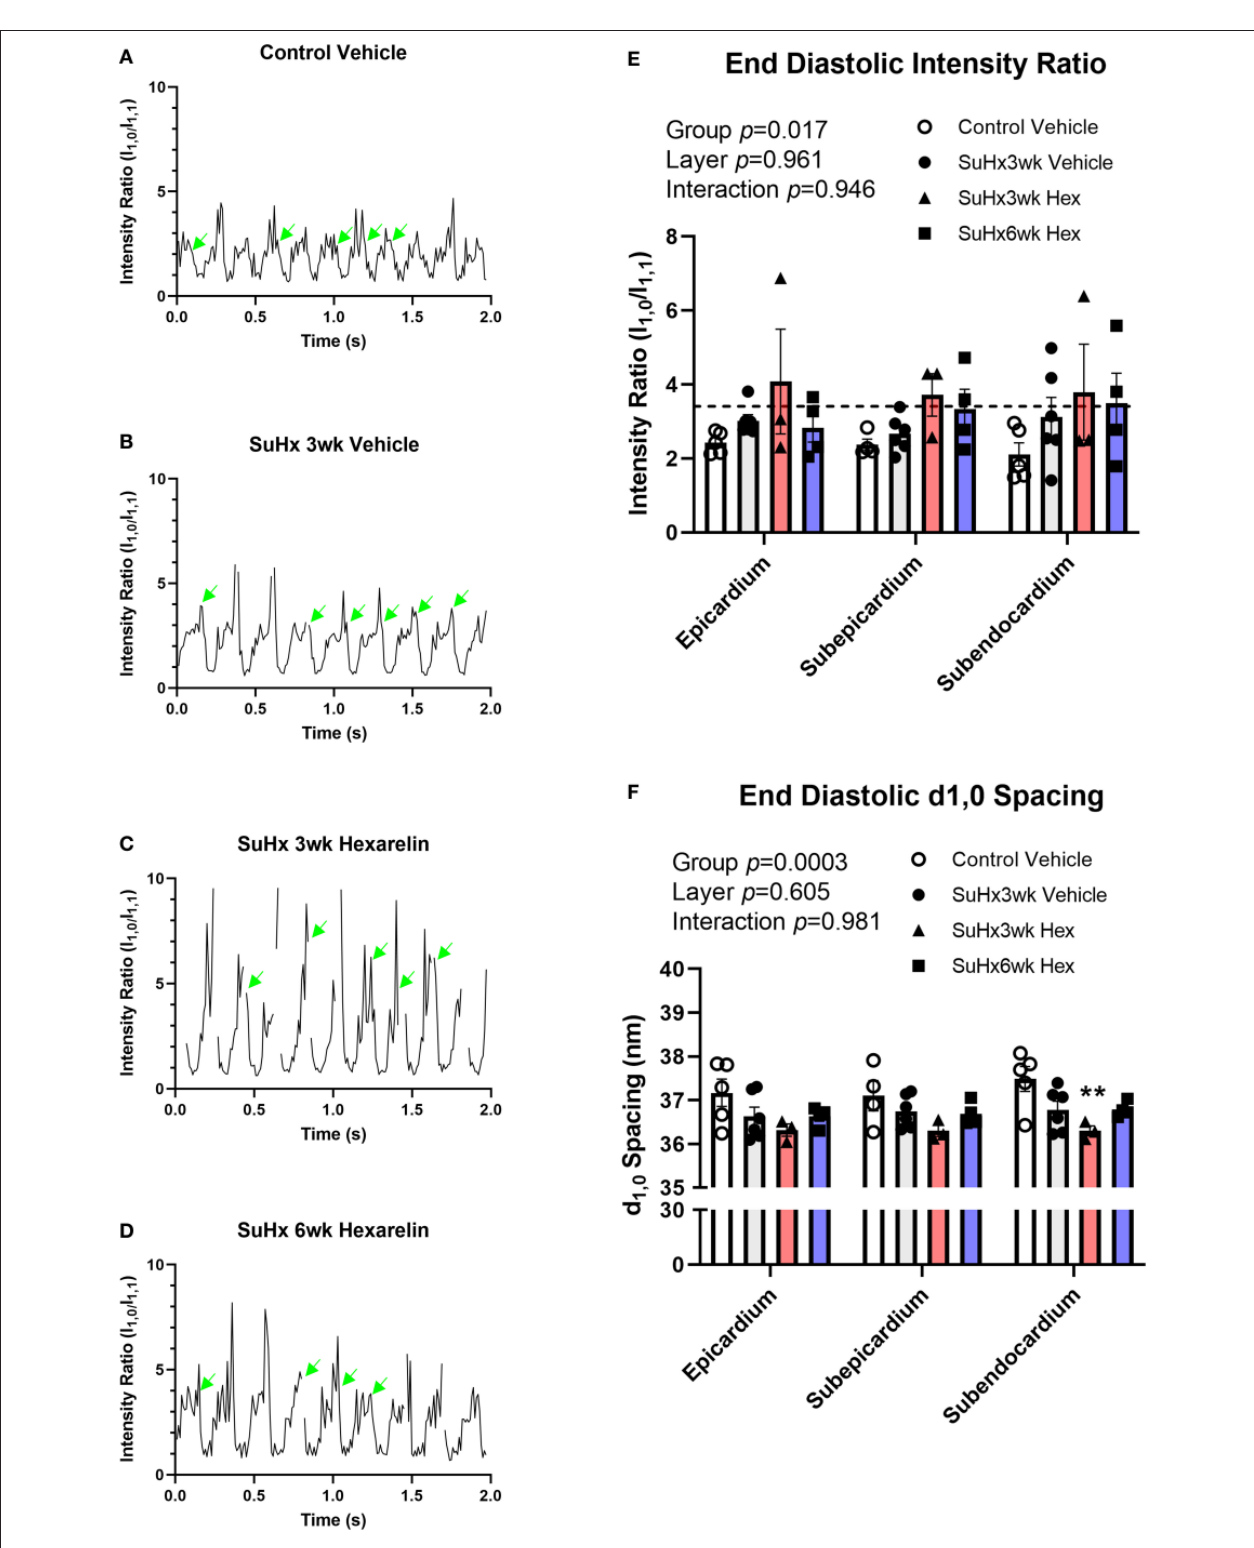
FIGURE 5 | Cyclic changes in the SAXS intensity ratio over several cardiac cycles for (A) control, (B) SuHx3wk vehicle, (C) SuHx3wk hex, and (D) SuHx6wk hex. Green arrows indicate the time points where the end diastolic (ED) intensity ratio could be established. Gaps indicate time points where artifacts prevented the